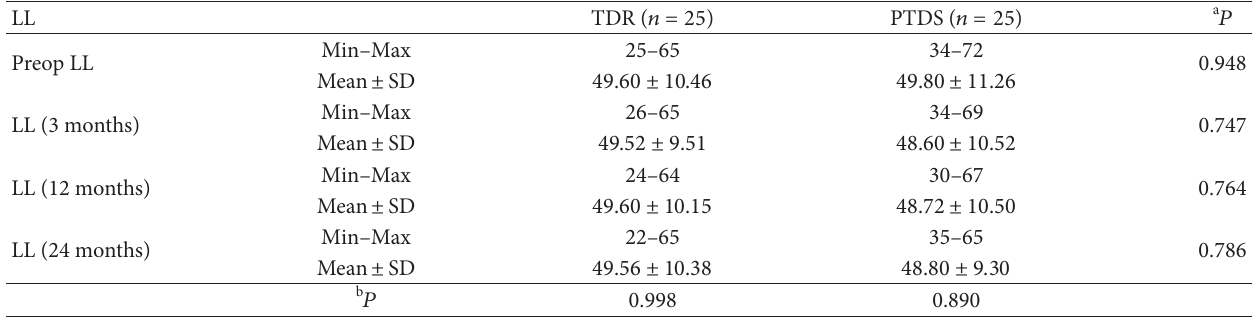
T 4: e comparison of LL angles.